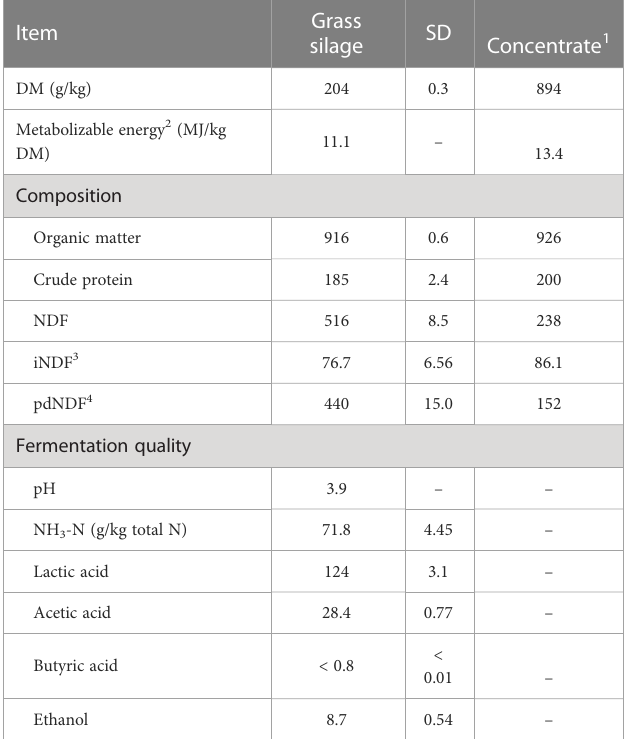
TABLE 3 Intake and production data for cows fed a grass silage-based diet without (control) or with supplementation with Asparagopsis taxiformis